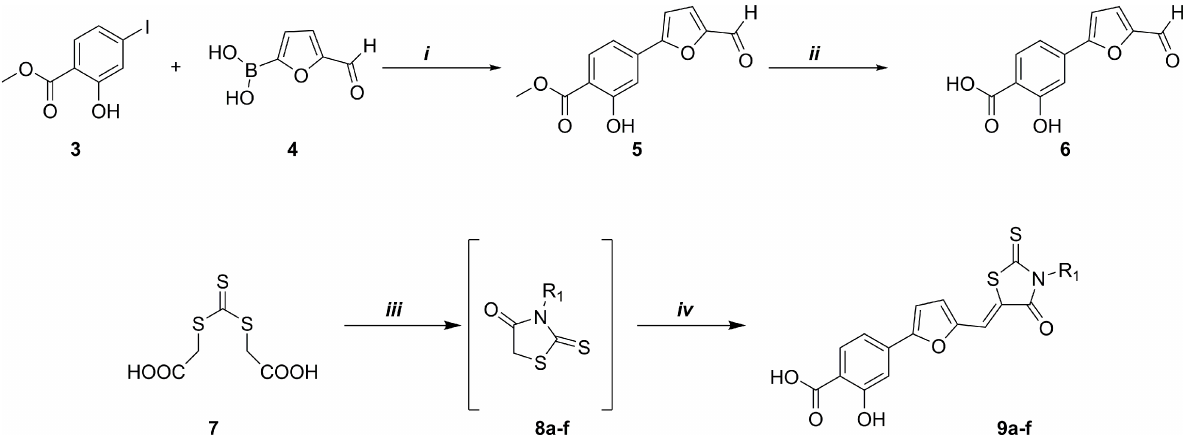
Fig 2. Synthesis of aldehyde 6 and derivatives 9a-f. Synthesis scheme of aldehyde 6 : i) Pd(PPh 3 ) 2 Cl 2 , Na 2 CO 3 , DMF/EtOH, RT, 1h; ii) 1N NaOH (aq), MeOH/THF, reflux 2h. Synthesis scheme of derivatives 9a-f : iii ) DME, Et 3 N, MW (300 W), 90˚C, 10 min. iv ) aldehyde 6, MW (300 W), 110˚C, 5